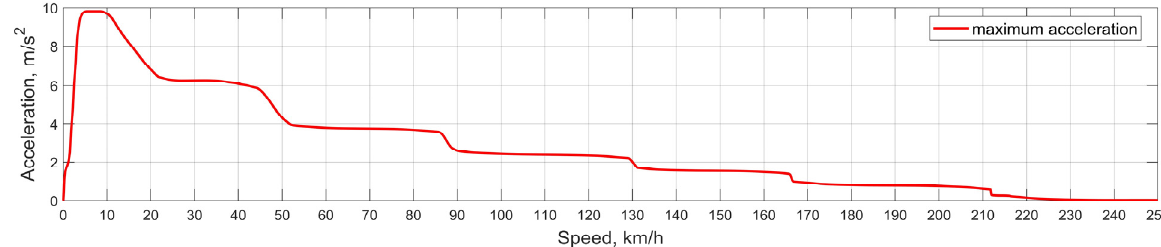
Figure 6. Audi A4 Quattro acceleration with full throttle use.